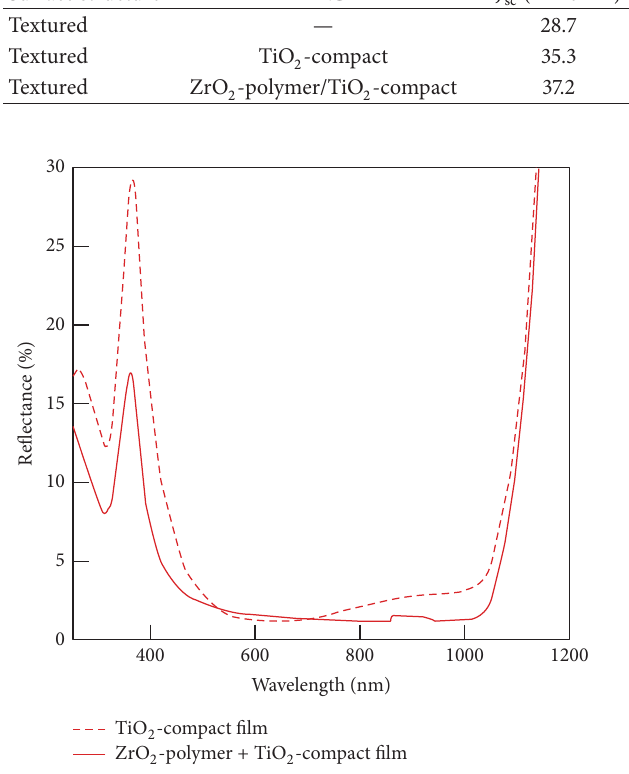
Figure 3: J-V curve comparison of the best cells with or without antireflection